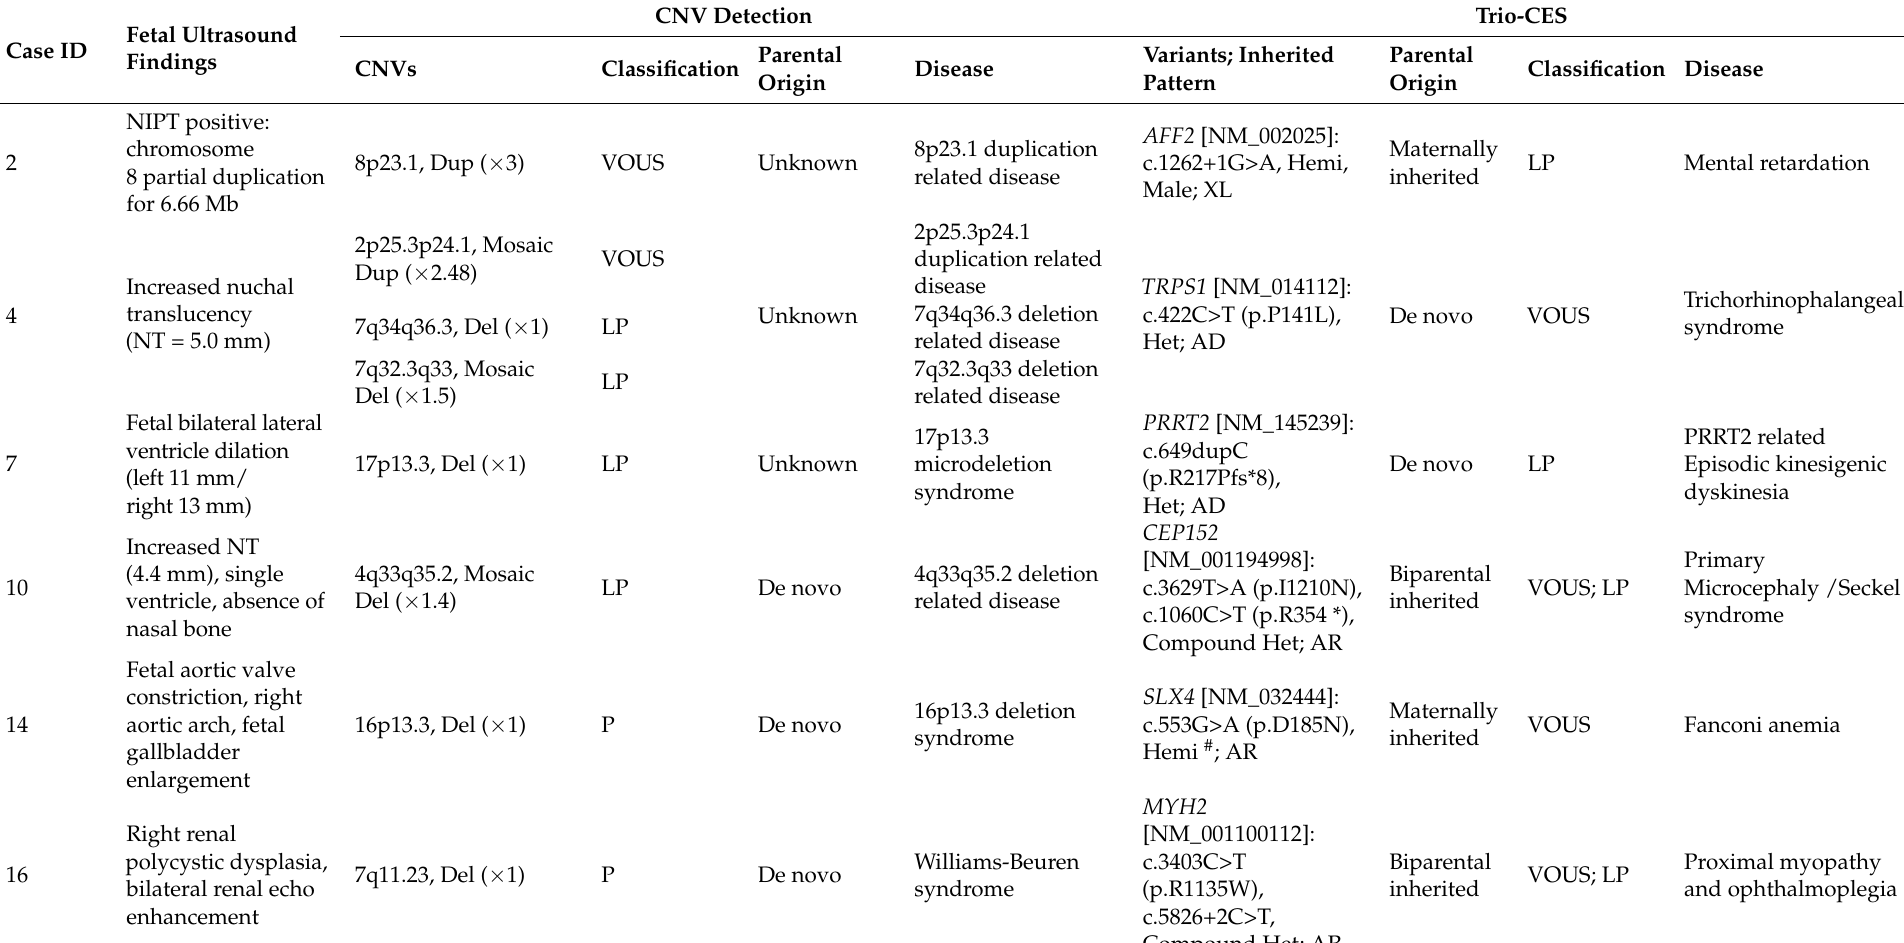
Table 2. The clinical significance of comprehensive genetic variants in 6